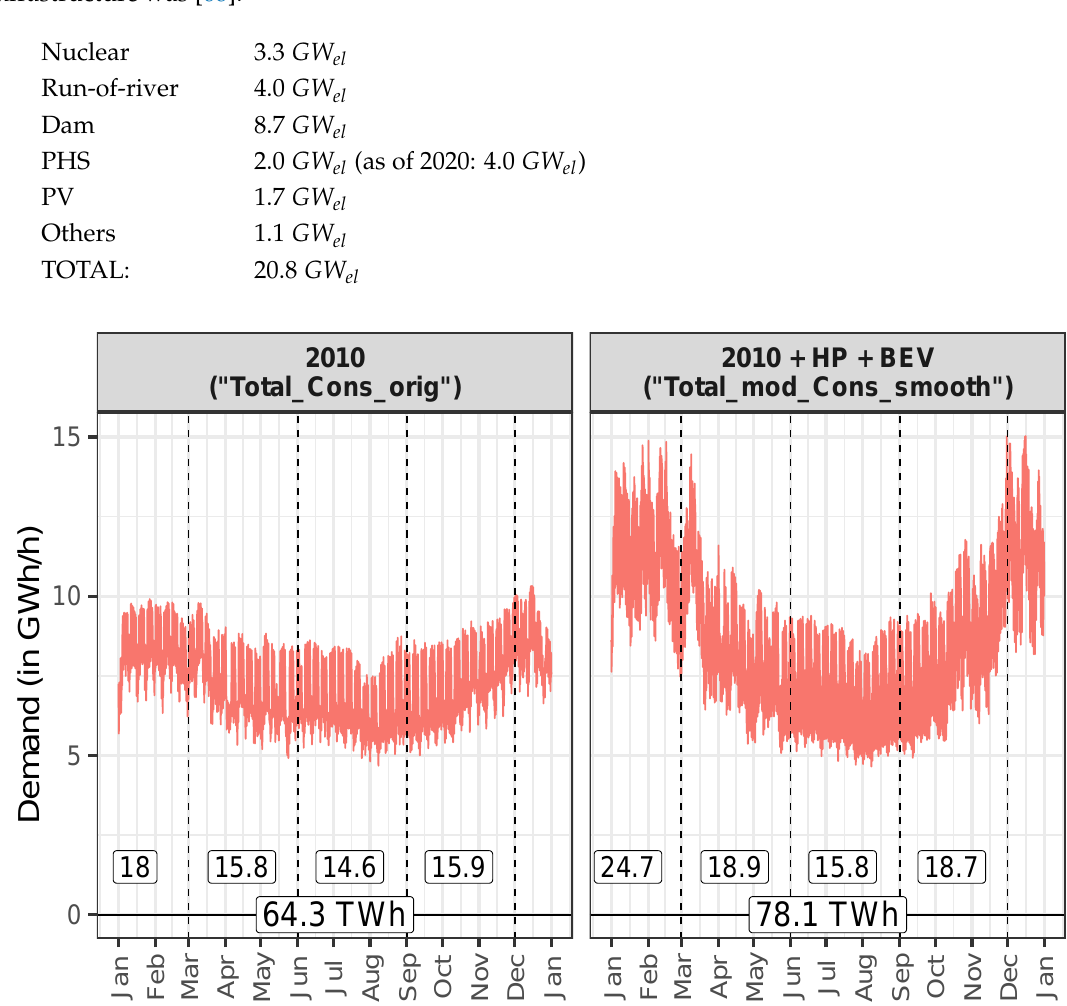
Figure 16. ( Left ): Hourly Swiss electricity demand for 2010 in the original profile of Swissgrid (“Total_Cons_orig” in Table 1). ( Right ): Modified profile with an additional electrification by heat pumps and BEV (“Total_mod_Cons_smooth” in Table 1). Labels are the seasonal and annual